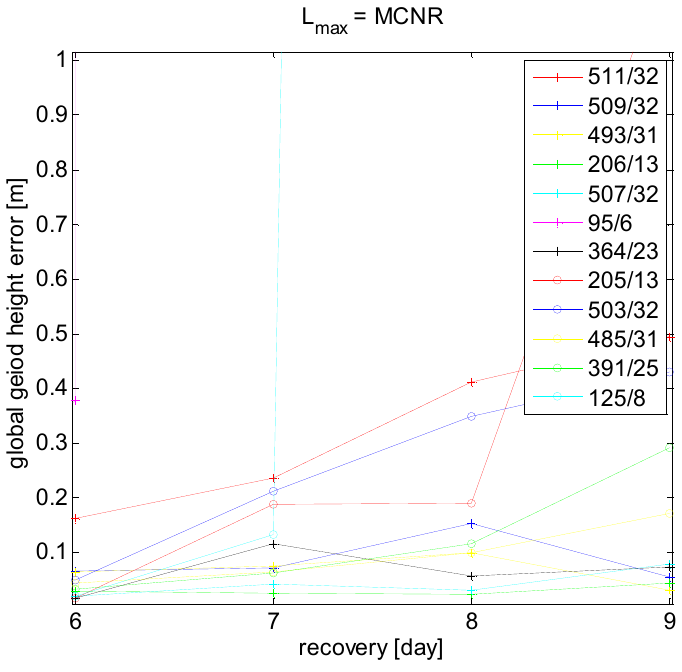
Figure 6. The zoom-in graph of the Figure 5.